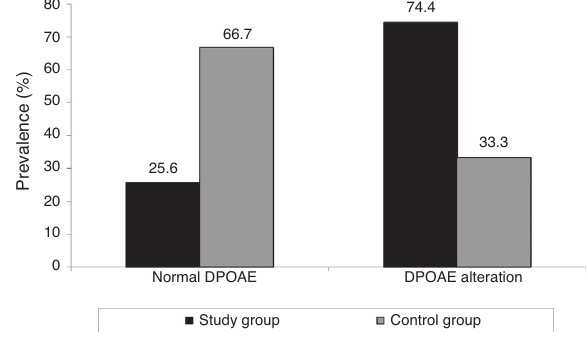
Alterations in HFA in study and control groups. HFA, high frequency audiometry.